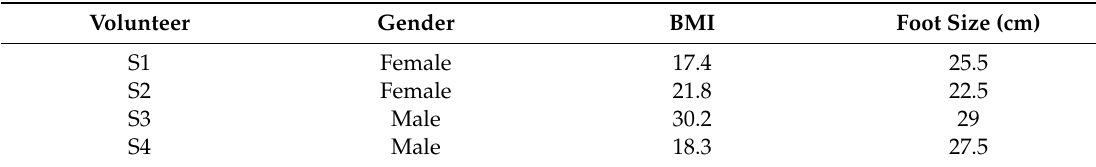
Figure 6. Manufactured prototypes. Table 4. Body Mass Index of the Volunteers.